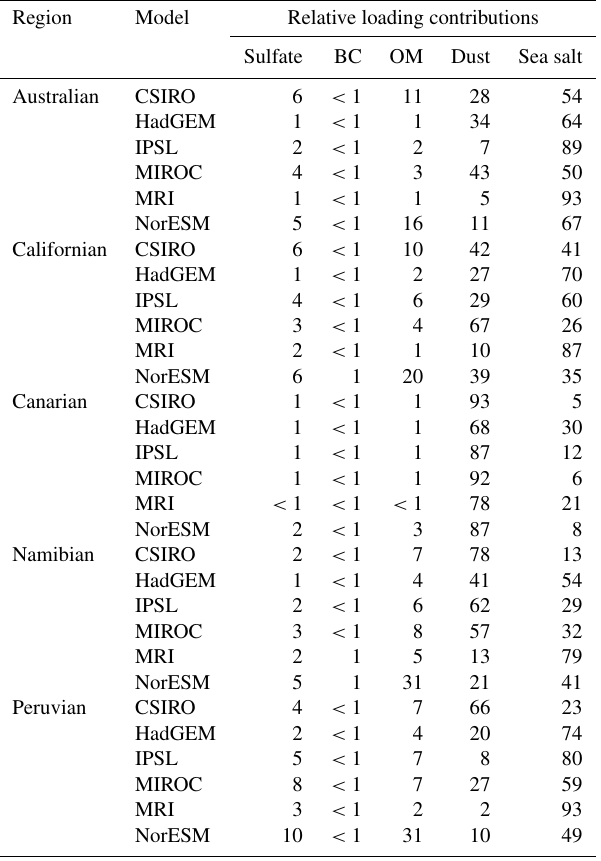
Table 2. Relative contributions to the total loading in percent for the control experiment. OM for NorESM includes only primary organic aerosol and for HadGEM only secondary organic